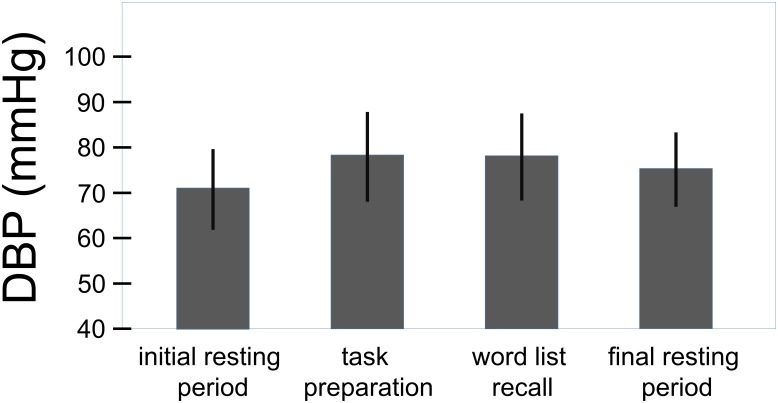
Overall effect of the challenge on the diastolic blood pressure (total sample, n = 70). Whiskers represent standard deviations. (F(3,207) = 53.4, p < 0.001, η2 = 0.439).